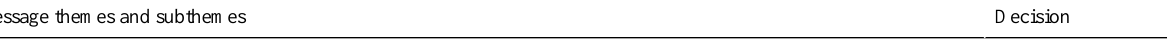
Table 2. Example text messages and decisions based on discrepant consumers’ versus health professionals and researchers’ mean ratings (out of 15) and supporting feedback